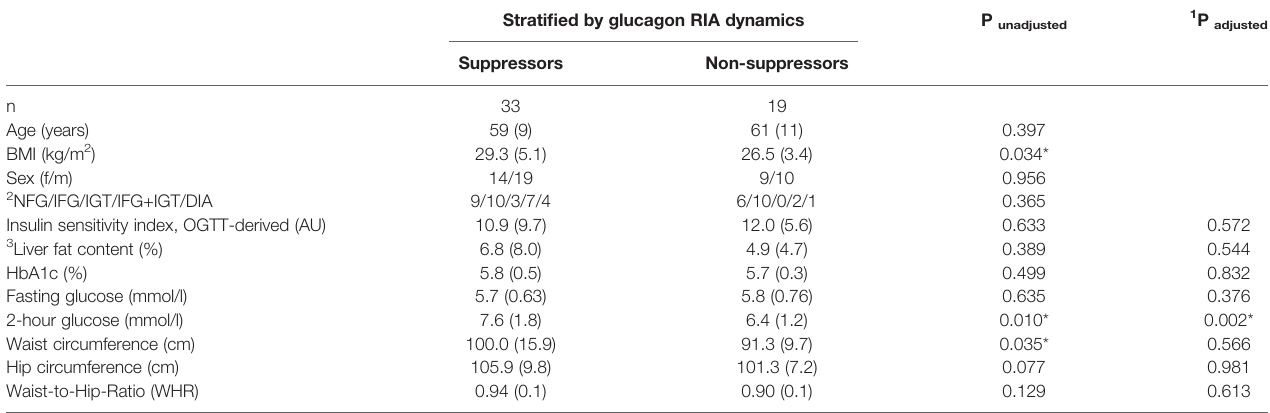
TABLE 1 | Subject characteristics.